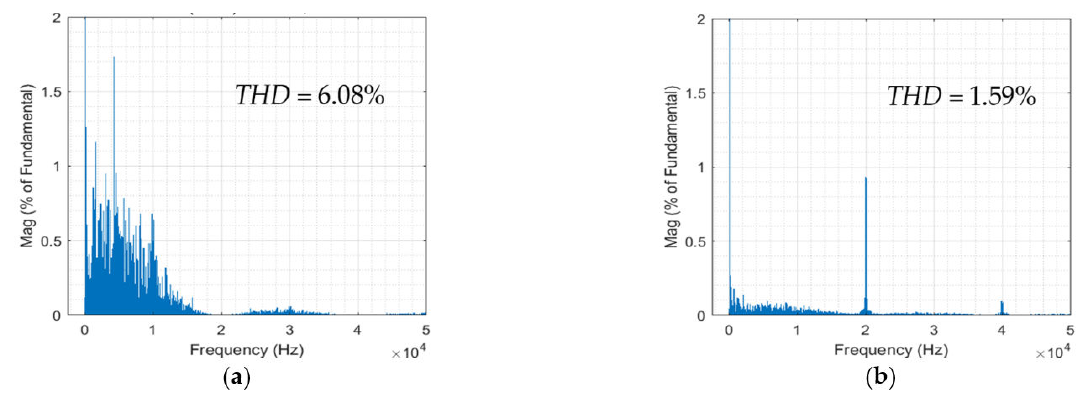
Figure 11. FFT analysis results of simulated current waveforms. ( a ) FCS-MPC; ( b ) the proposed